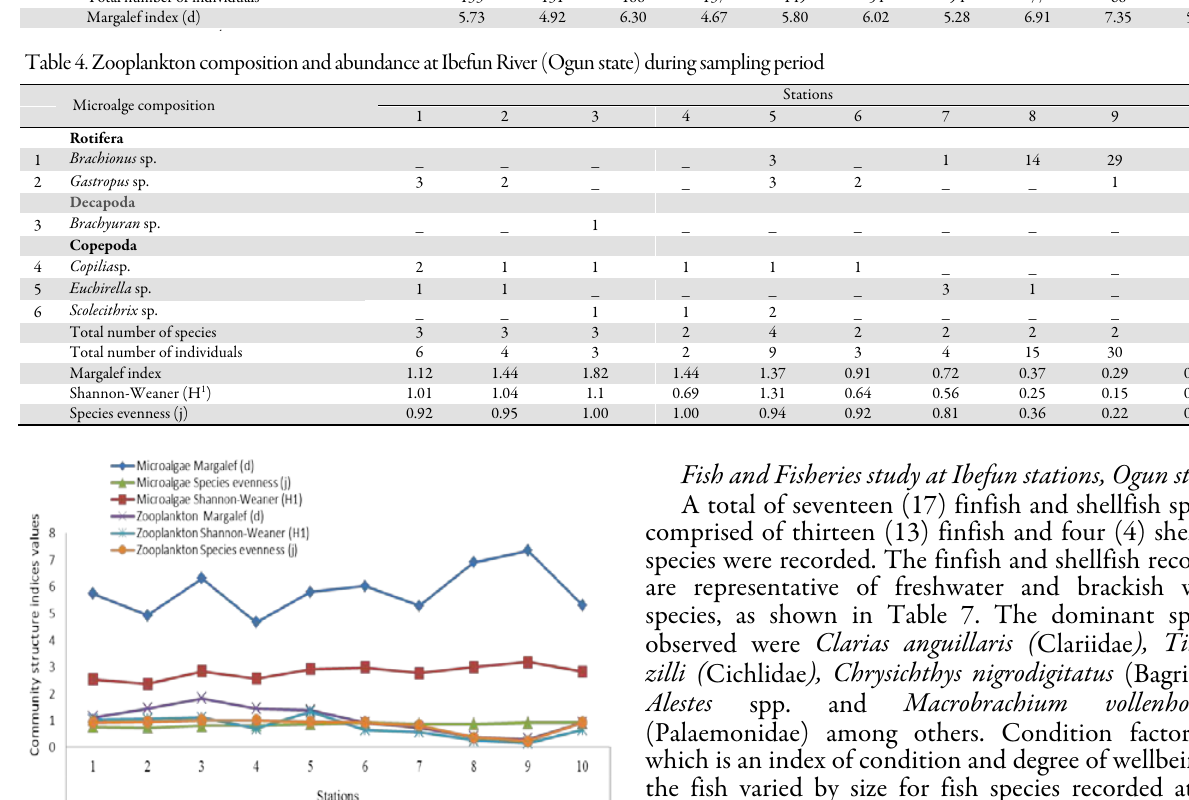
Euglena proxima Dang Euglena sp. Phacus orbicularis Hubner Trachelomonas sp.